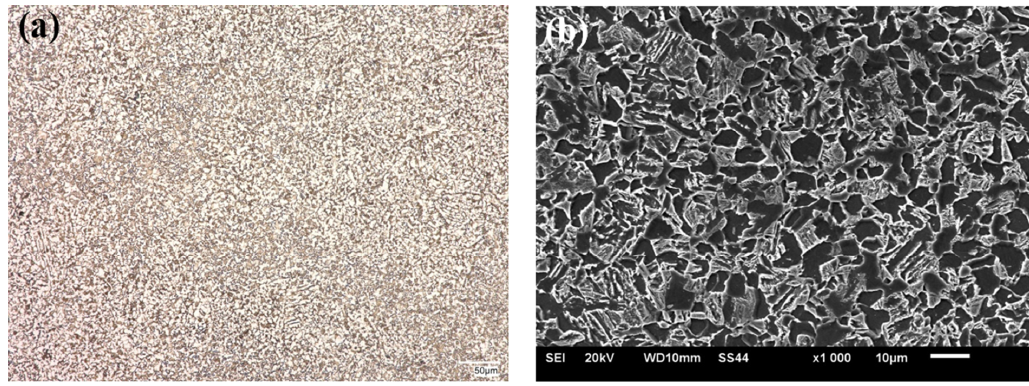
Figure 7. Microstructure of HAZ in A6 casting, ( a ) OM; ( b ) SEM.